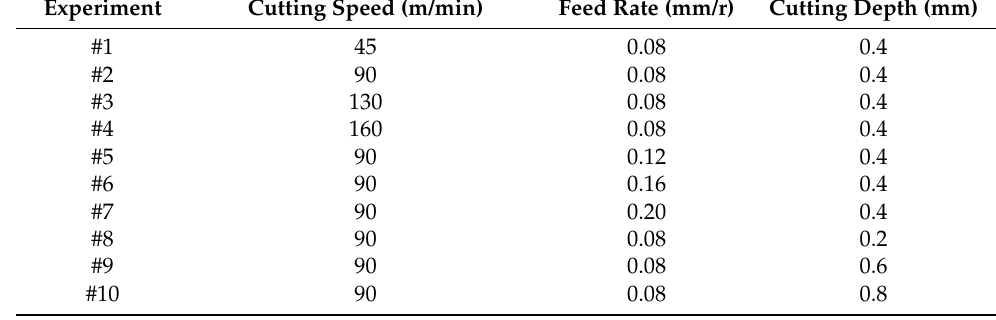
Table 3. Experimental design.